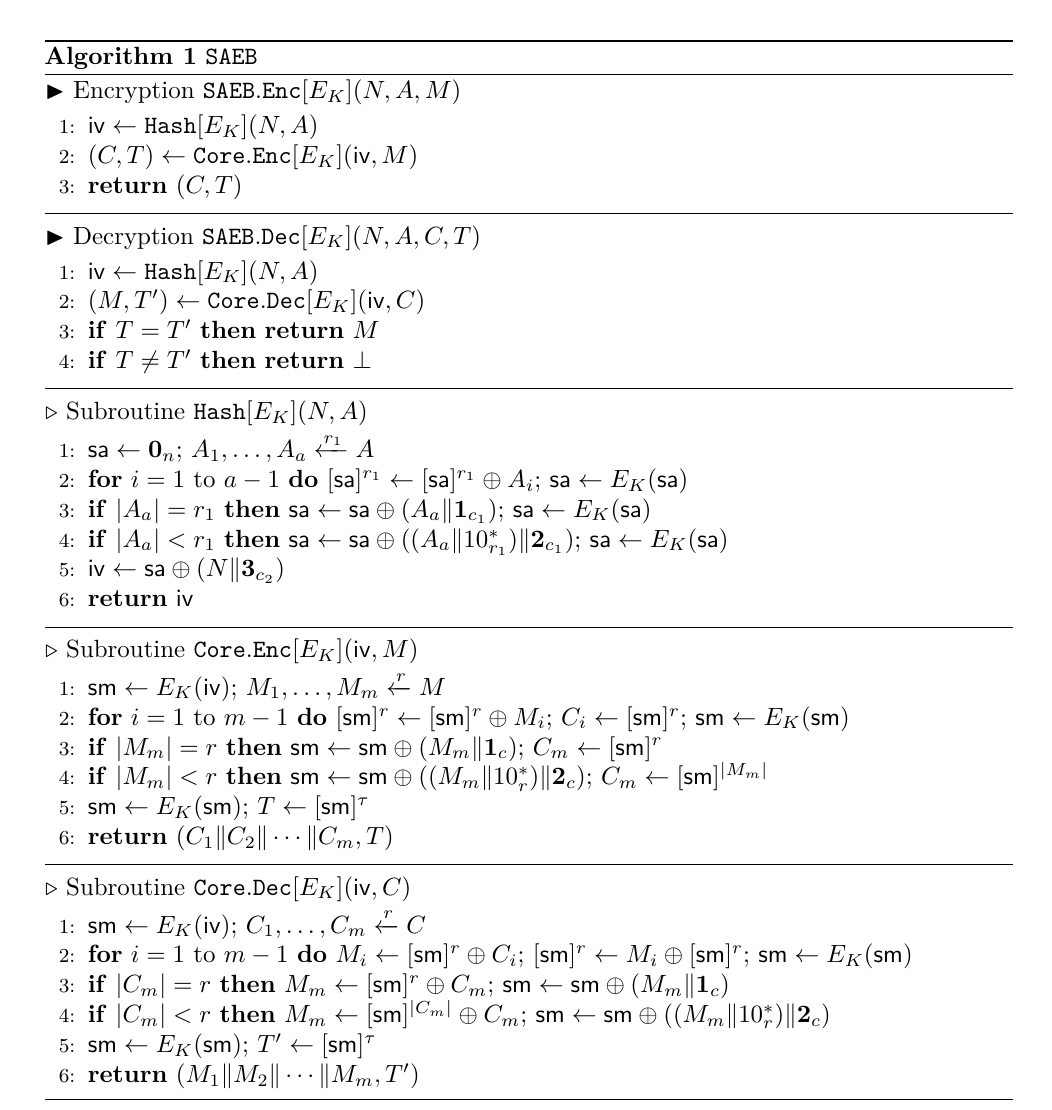
SAEB : A Lightweight Blockcipher-Based AEAD Mode of Operation